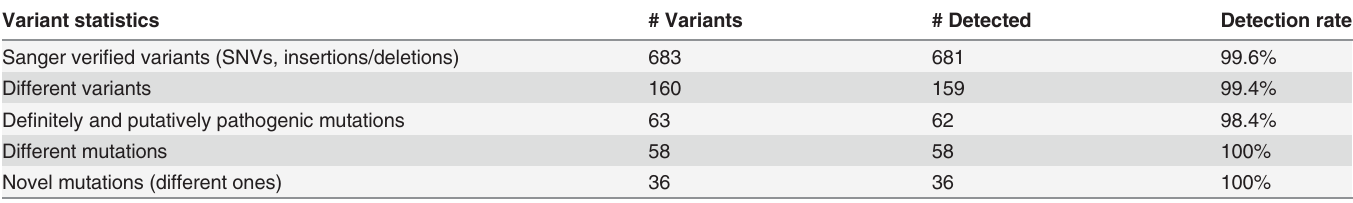
Table 1. Validation statistics in PKD1 mutation-positive patient